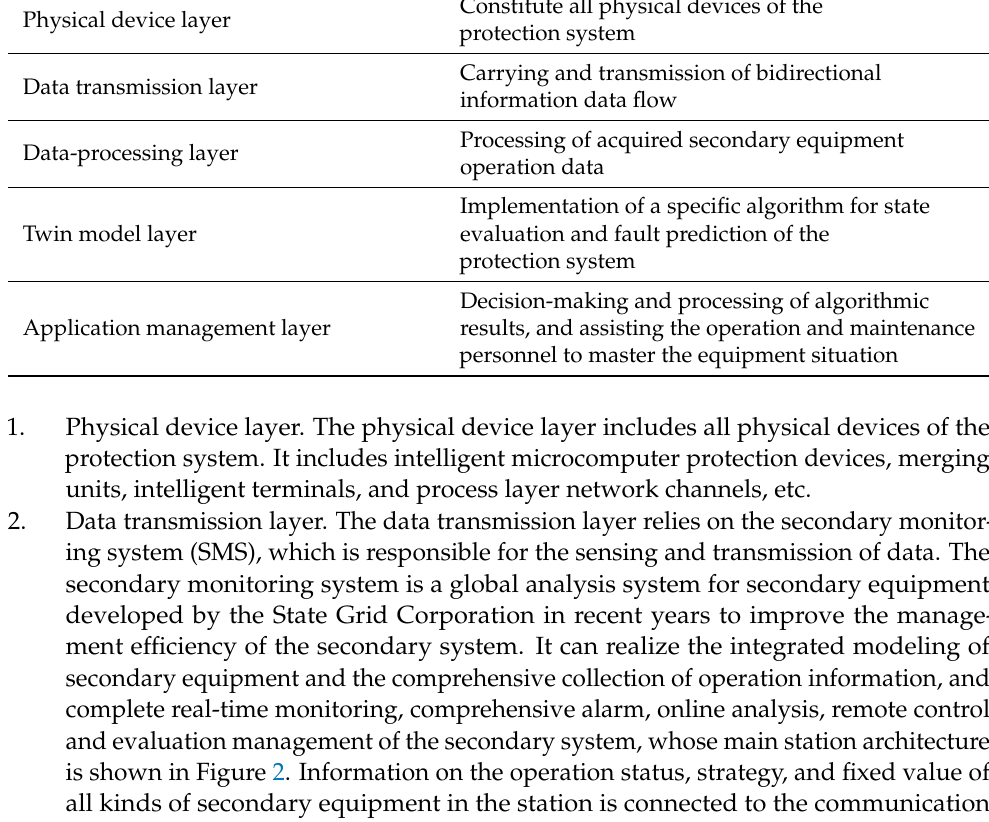
Figure 1. Digital Twin Architecture and Working Principle of Protection System. The main functions of each layer in the architecture of a digital twin protection sys- tem are shown in the Table 1. Table 1. The main functions of each layer.